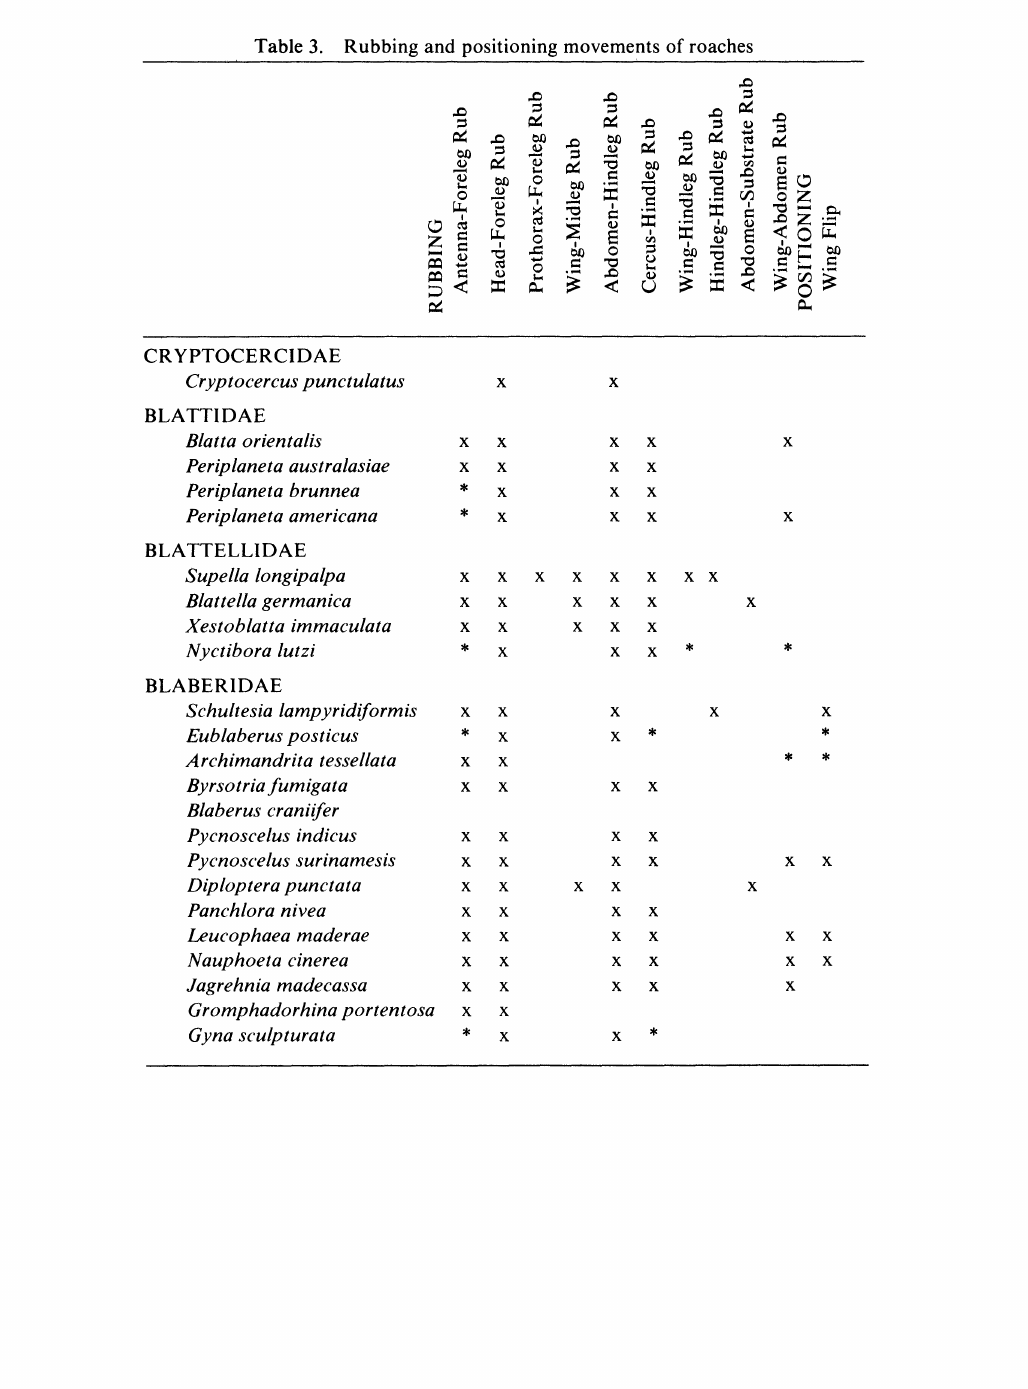
Table 3. Rubbing and positioning movements of